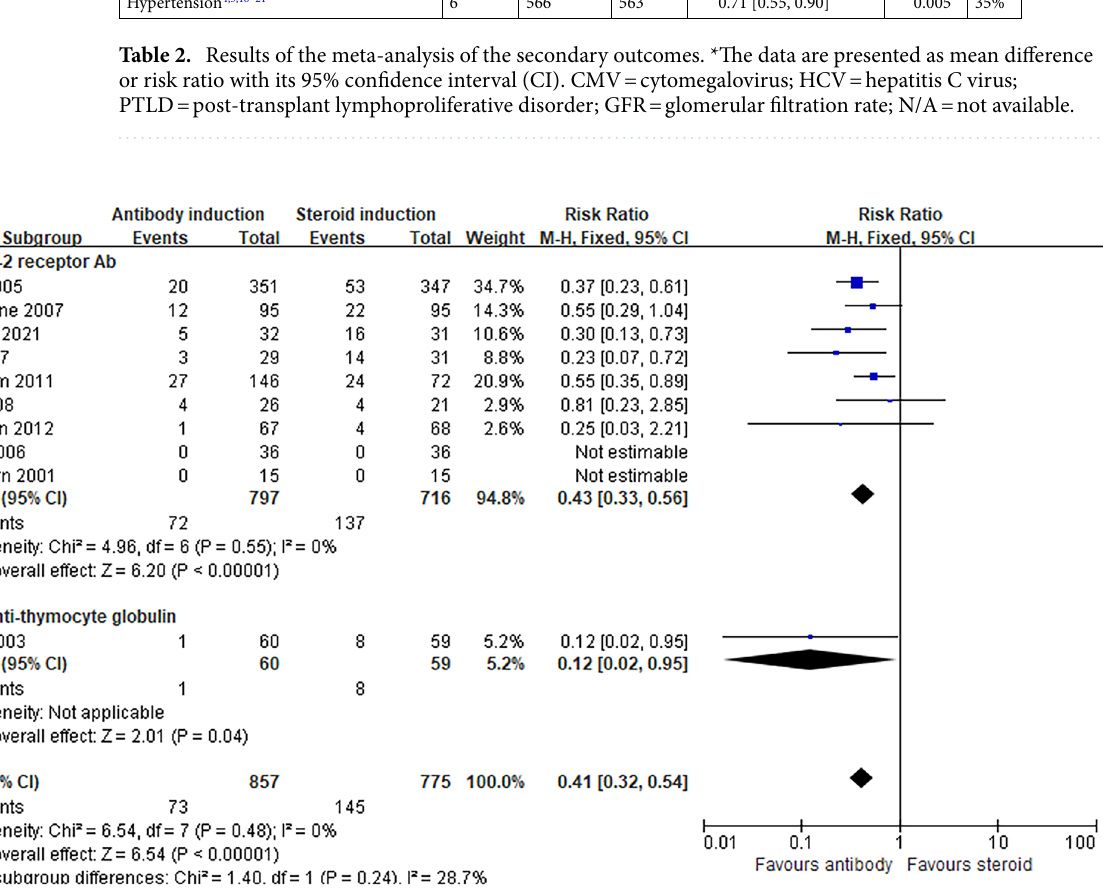
Figure 3. Forest plot of comparison between antibody induction versus corticosteroid induction: new onset Diabetes